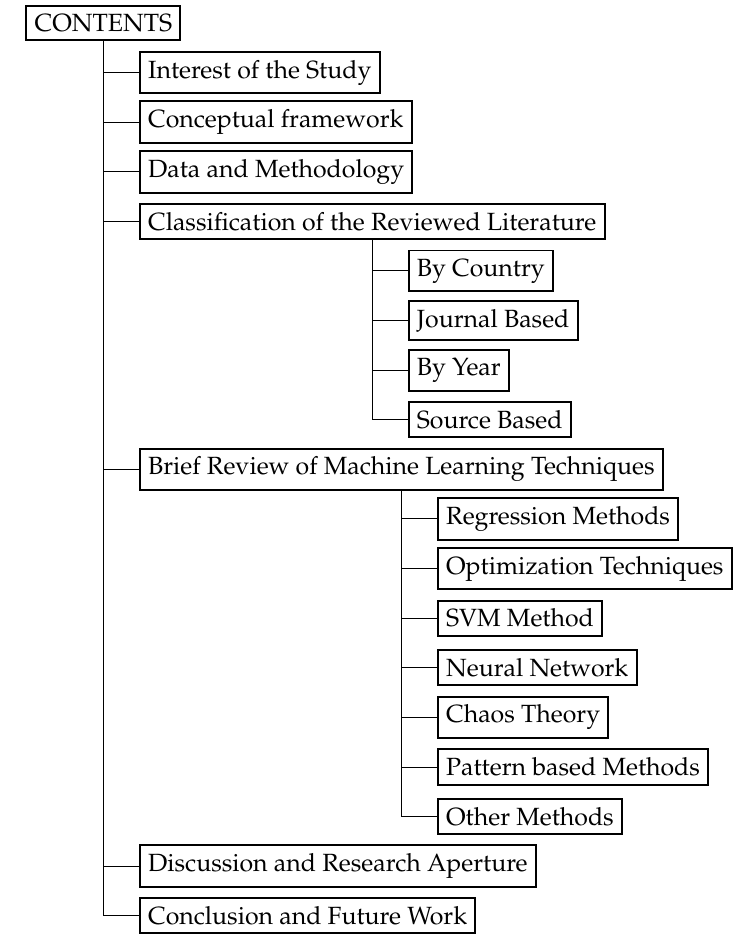
Figure 1. Organization of the research. Table 1. Summary of the keyword-based